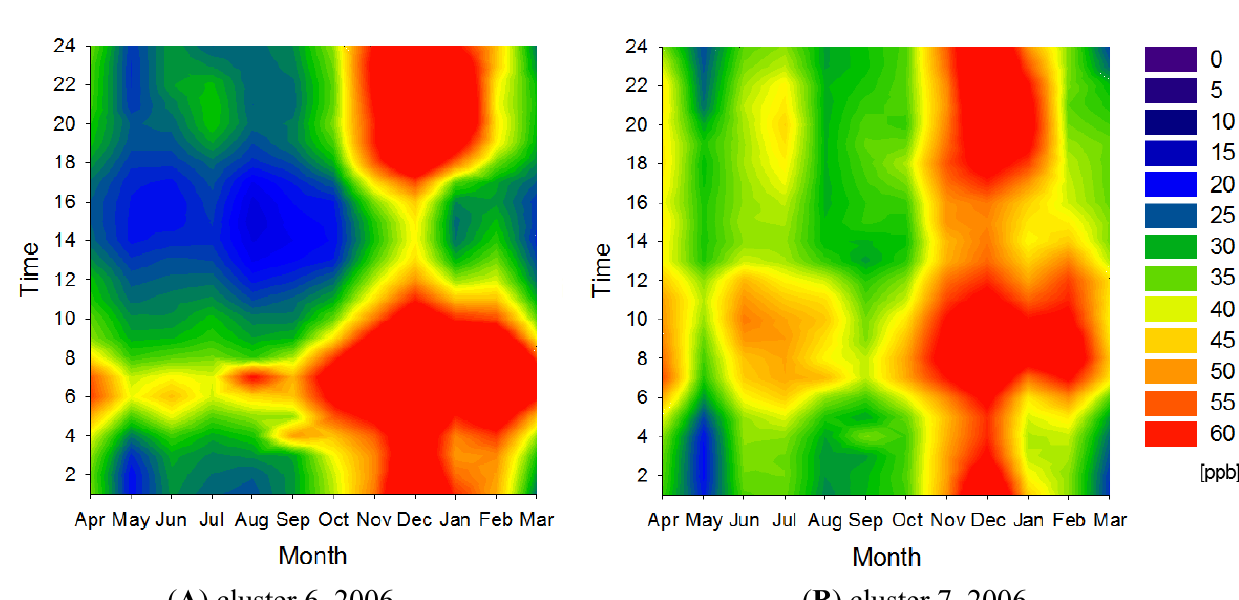
Figure 3. NO concentration contour maps for clusters 6 ( A ) and 7 ( B ) in x